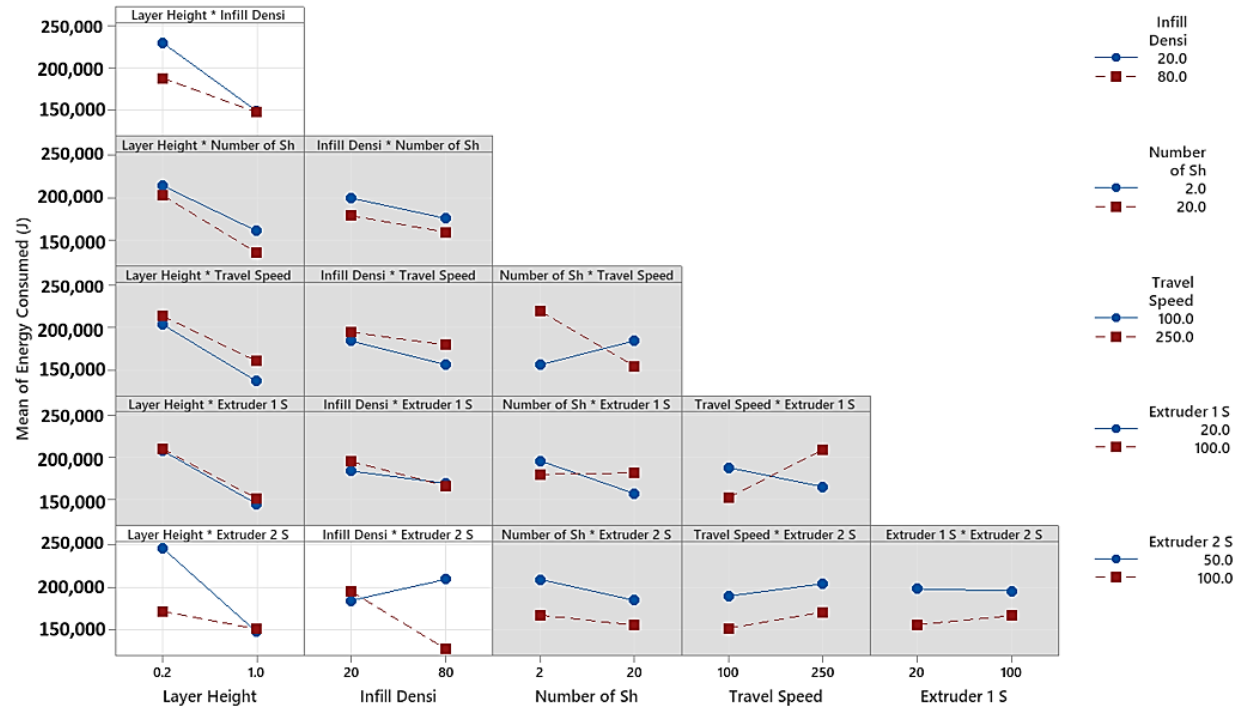
Figure 7. Interaction plot for two factors regarding energy consumption. Note: * indicates a combination of two parameters.